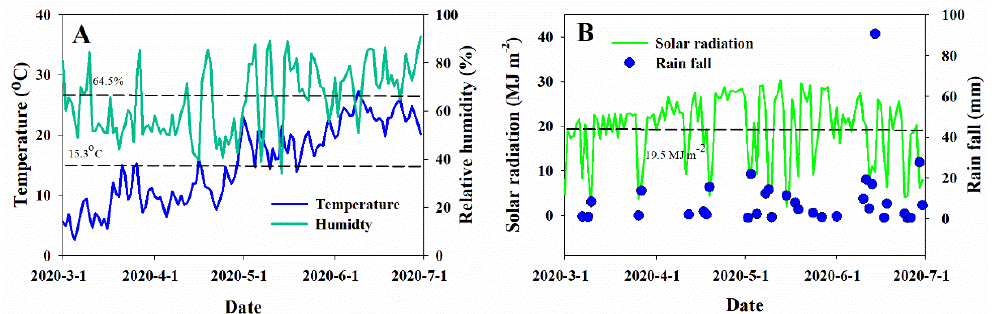
Figure 1. Changes in air temperature and air humidity ( A ), and cumulative radiation and rainfall ( B ) of the experimental field during the cultivation period. Horizontal dotted lines the experimental field during the cultivation period. Horizontal dotted lines represent average represent average values.